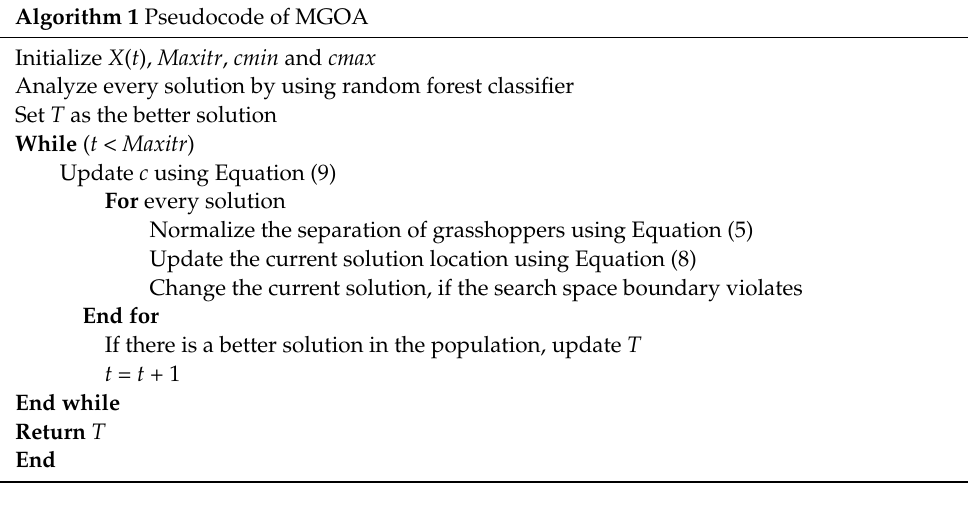
Algorithm 1 Pseudocode of